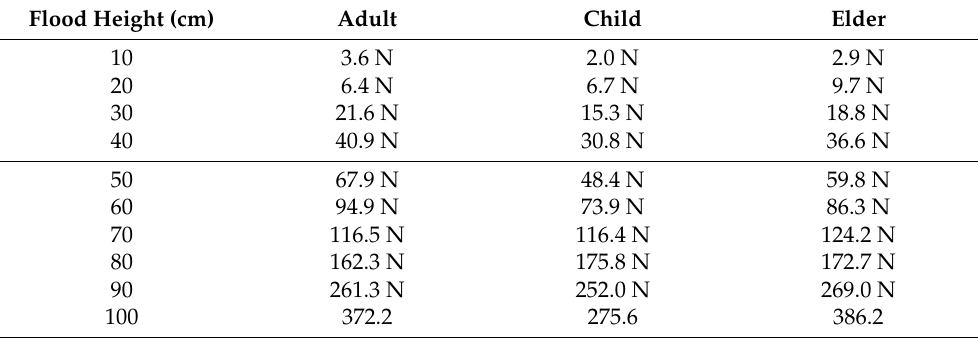
Figure 21. Hydrodynamic pressure of elder walking at a minimum safe speed at different flood heights. Table 9. Flood resistance of all groups walking at a critical speed at different flood heights. Flood Height (cm)